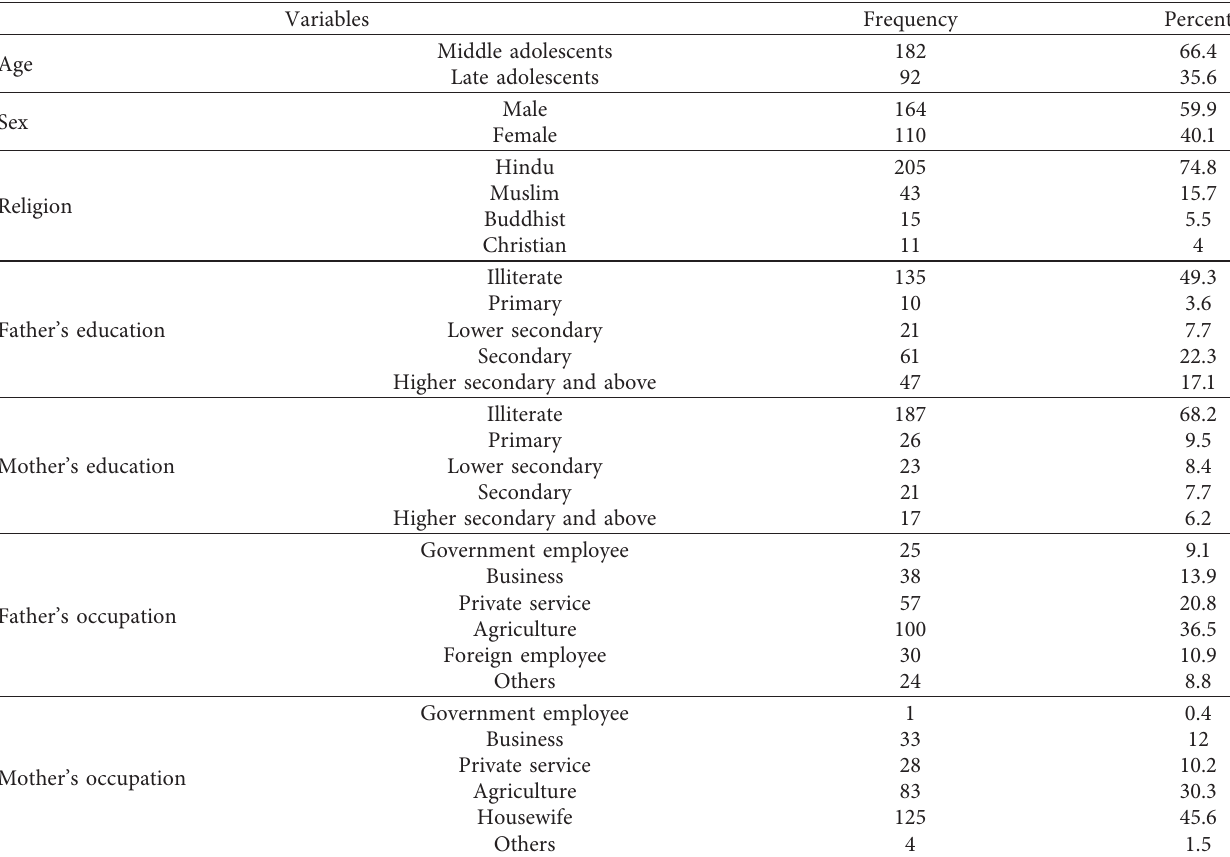
Table 1: Sociodemographic